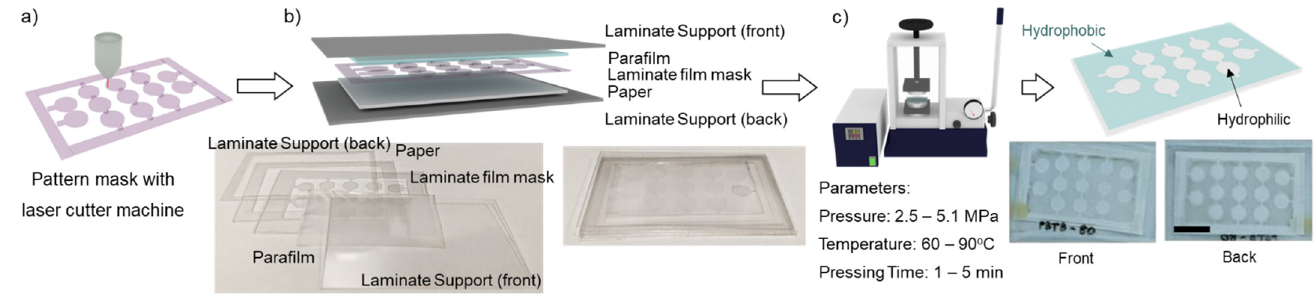
Figure 1. Schematic diagram of the fabrication process. ( a ) Pattern laminate films were cut with laser cutter machine; ( b ) The laminate supports, parafilm, patterning laminate film, and paper were stacked and covered with aluminium foil orderly (aluminium foil is not shown); ( c ) The stacked paper was placed in a hot press machine to locally determine hydrophobic to the paper. Scale bar is 1 cm.